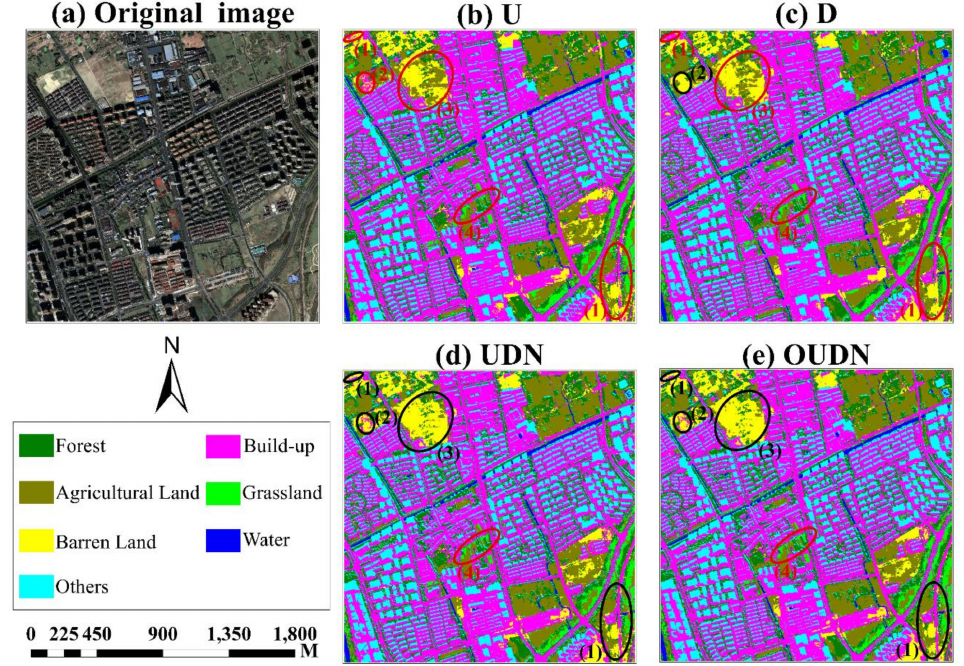
Figure 9. ( a ) Original image; ( b ) the classification map of the U algorithm based on the Spe-Index; ( c ) the classification map of the D algorithm based on the Spe-Index; ( d ) the classification map of the UDN algorithm based on the Spe-Index; ( e ) the classification map of the OUDN algorithm based on the Spe-Index; and the red and black circles denote incorrect and correct classifications,